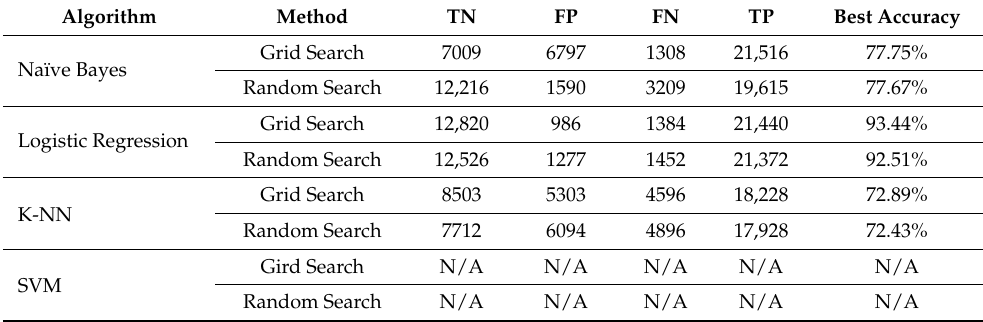
Table 6. Summary of results after introducing hyperparameter